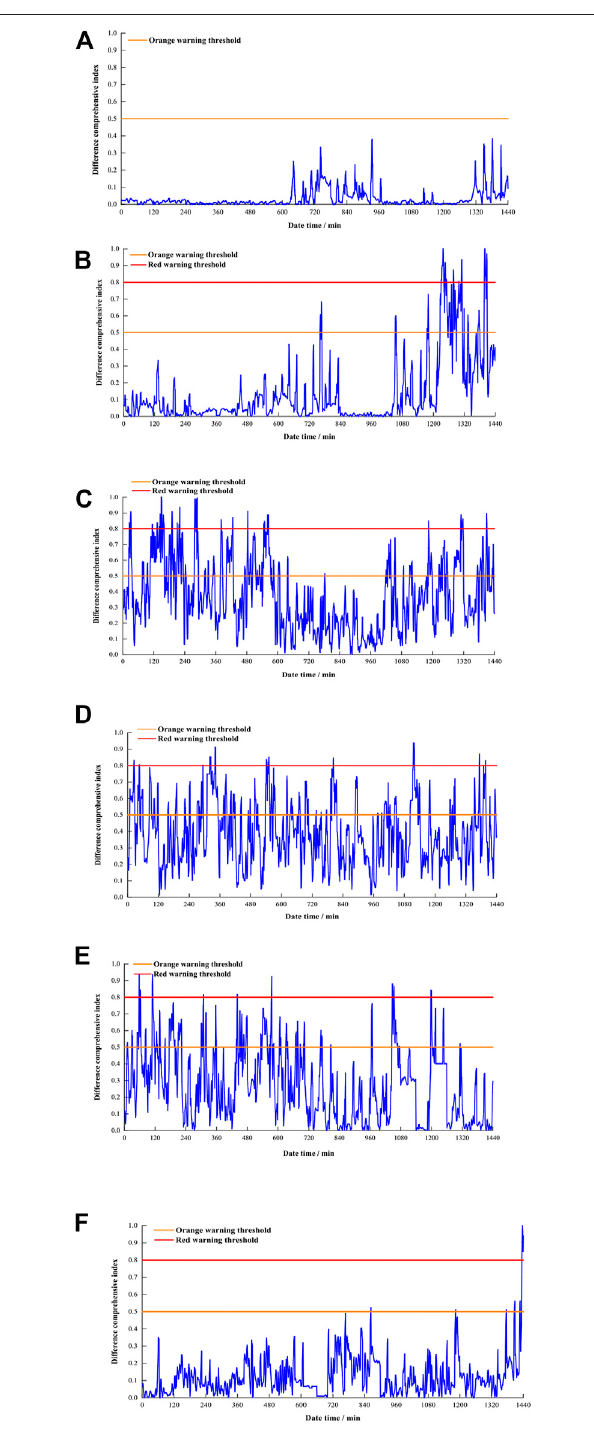
FIGURE 16 | Analysis of outburst warning results on March 19 – 24. (A) Analysis of outburst warning results on March 19 (B) Analysis of outburst warningresultsonMarch20 (C) AnalysisofoutburstwarningresultsonMarch 21 (D) Analysis of outburst warning results on March 22 (E) Analysis of outburst warning results on March 23 (F) Analysis of outburst warning results on March 24.